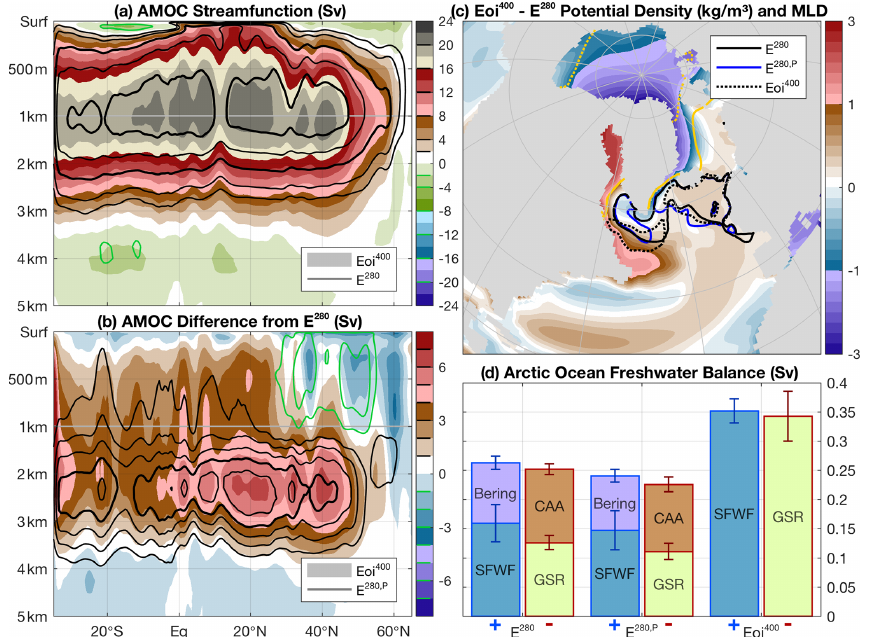
Figure 8. (a) Mean AMOC stream function over the last 500 years of the Eoi 400 (shading) and E 280 simulation (contours highlighted on the colour bar). (b) Difference in AMOC stream function with respect to the E 280 for the Eoi 400 (shading) and the E 280 , P (contours). (c) Eoi 400 − E 280 (100-year mean) potential density difference, averaged over the upper 100m and relative to the global average change. Contours show the annual mean maximum mixed-layer depth for the E 280 (solid black), E 280 , P (solid blue), and Eoi 400 (dotted black) and the 0.15 sea ice fraction (yellow; solid: E 280 ; dashed: Eoi 400 ). (d) Freshwater budget over the Arctic Ocean for the (left to right) E 280 , E 280 , P , and Eoi 400 cases, including the net surface freshwater flux (SFWF) and transports across the Bering Strait, Canadian Archipelago (CAA), and Greenland–Scotland Ridge (GSR). The mean over the last 500 model years is taken, with the standard deviation of yearly averages indicated by the error